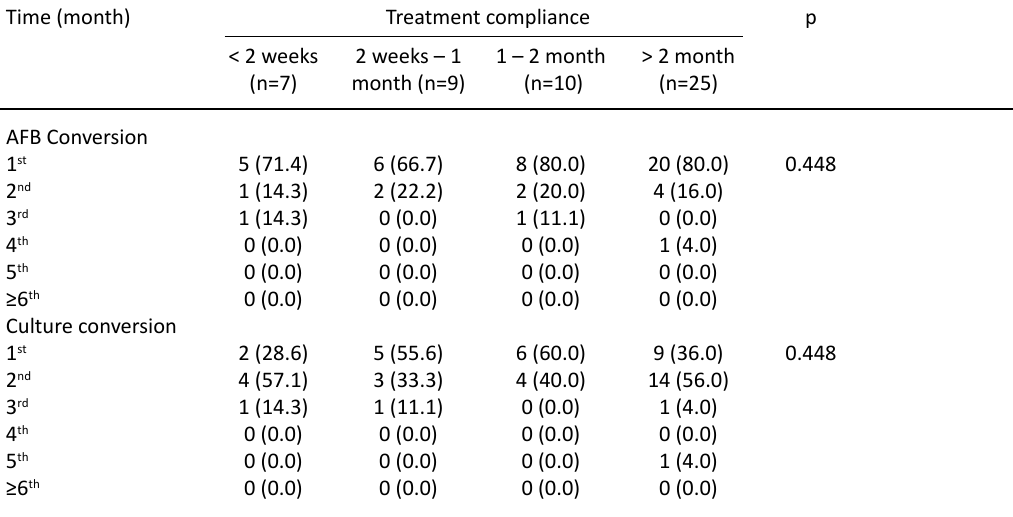
table 4. Correlation of treatment compliance on time to AFB conversion and culture conversion Time